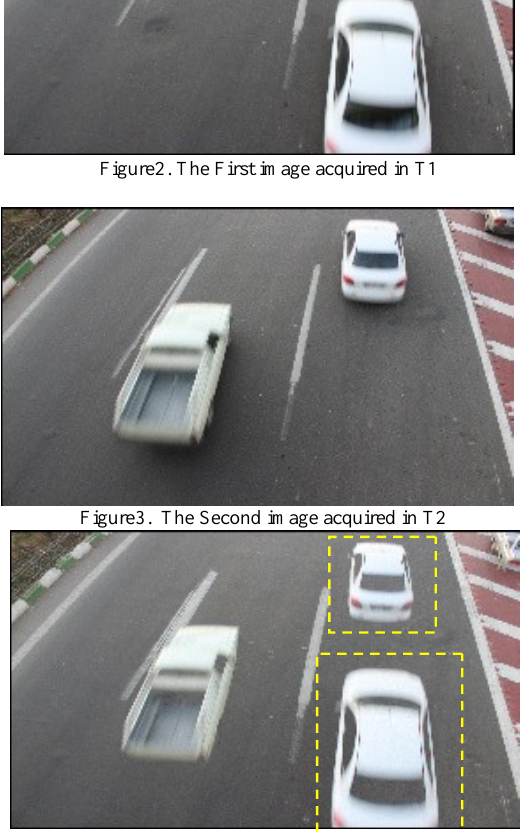
Figure4. The fused image based on wavelet theory